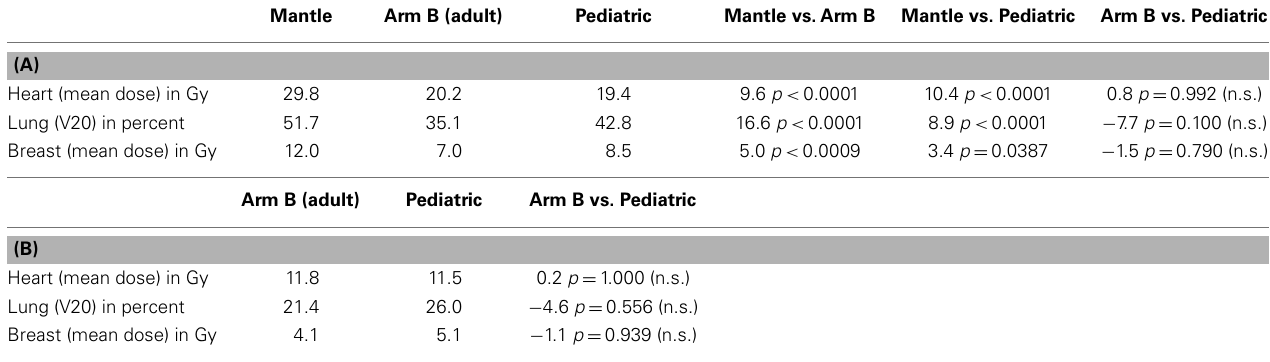
Table 3 | (A) Impact of treatment arm on normal tissue dose for 36Gy prescription; (B) impact of treatment arm on normal tissue dose for 21Gy prescription .